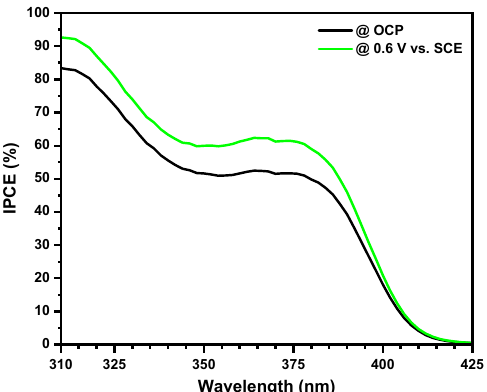
Figure 2. Incident photon to current efficiency (IPCE) of the TiO 2 catalyst as a function of incident light wavelength at open circuit and 0.6 V vs. saturated calomel electrode (SCE).